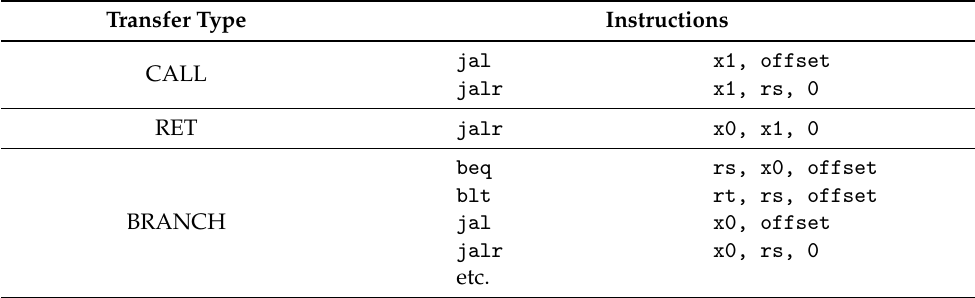
Table 1. The list of instructions for call and return in